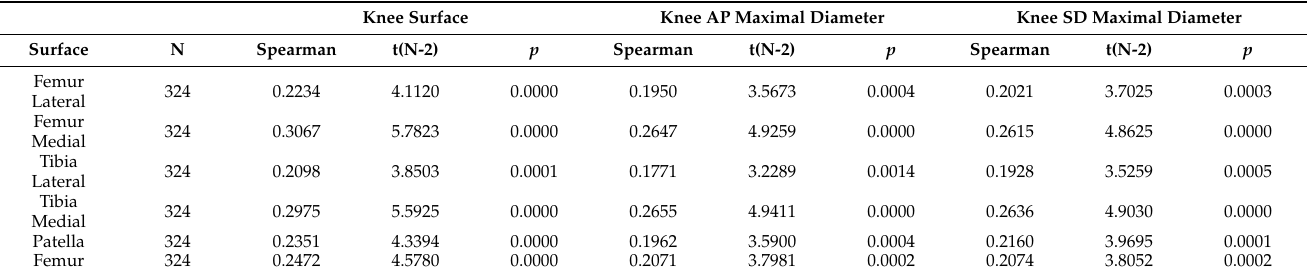
Table 3. Relationship between knee measurement and Outerbridge Scale in each compartment of the